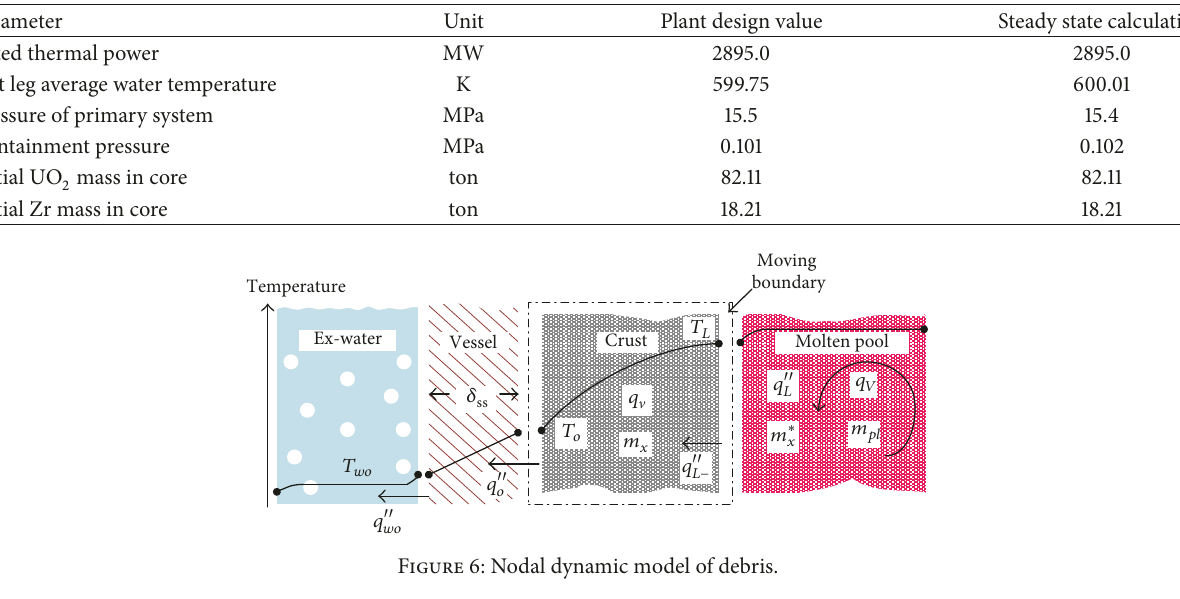
Table 1: Key parameters under the steady-state for comparison.